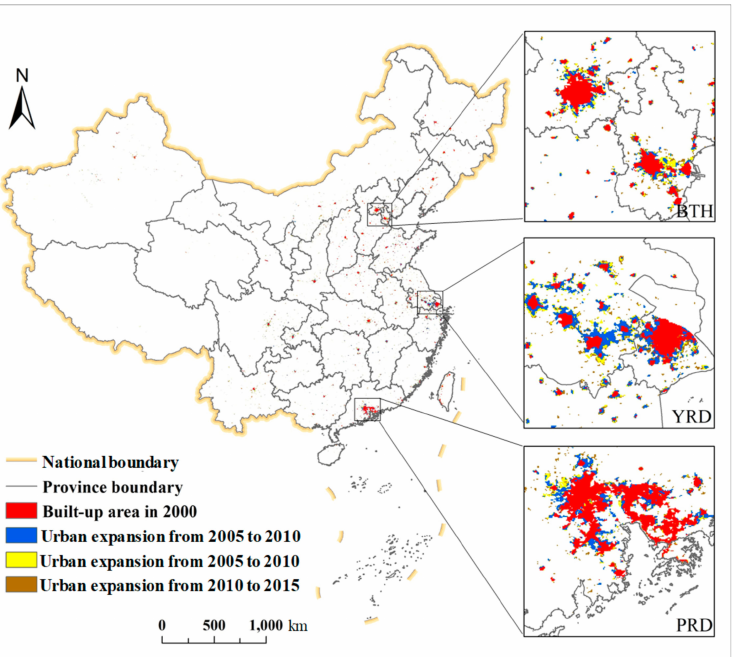
Figure 2. Urban expansion in China from 2000 to 2015. Note: The red represents urban areas in 2000; the blue represents urban areas in 2005; the yellow represents urban areas in 2010; and the brown represents urban areas in 2015. The three magnified urban agglomeration areas are BTH, the YRD, and the